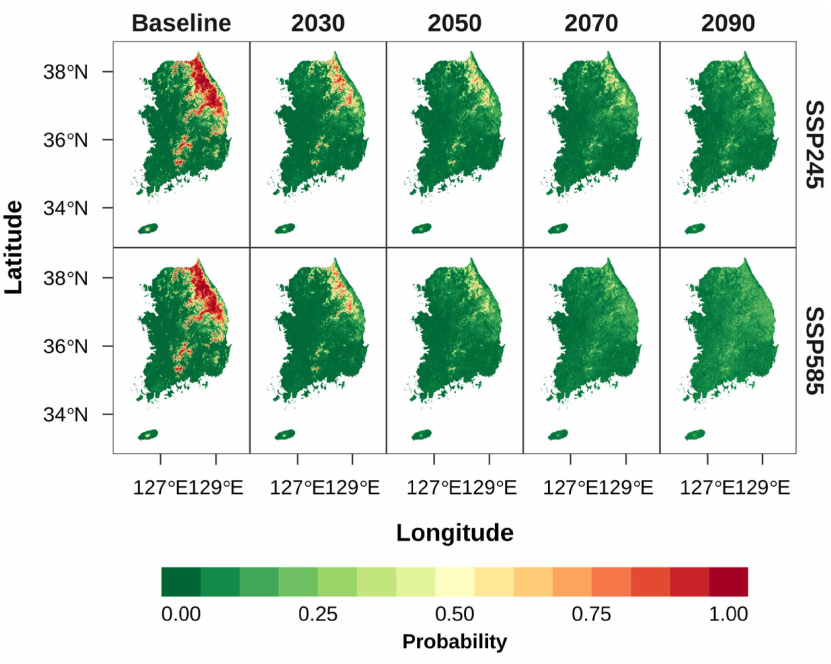
Figure 5. Mean habitat suitability for Angelica gigas under the SSP245 and SSP585 scenarios of multiple GCMs using the committee averaging ensemble approach.